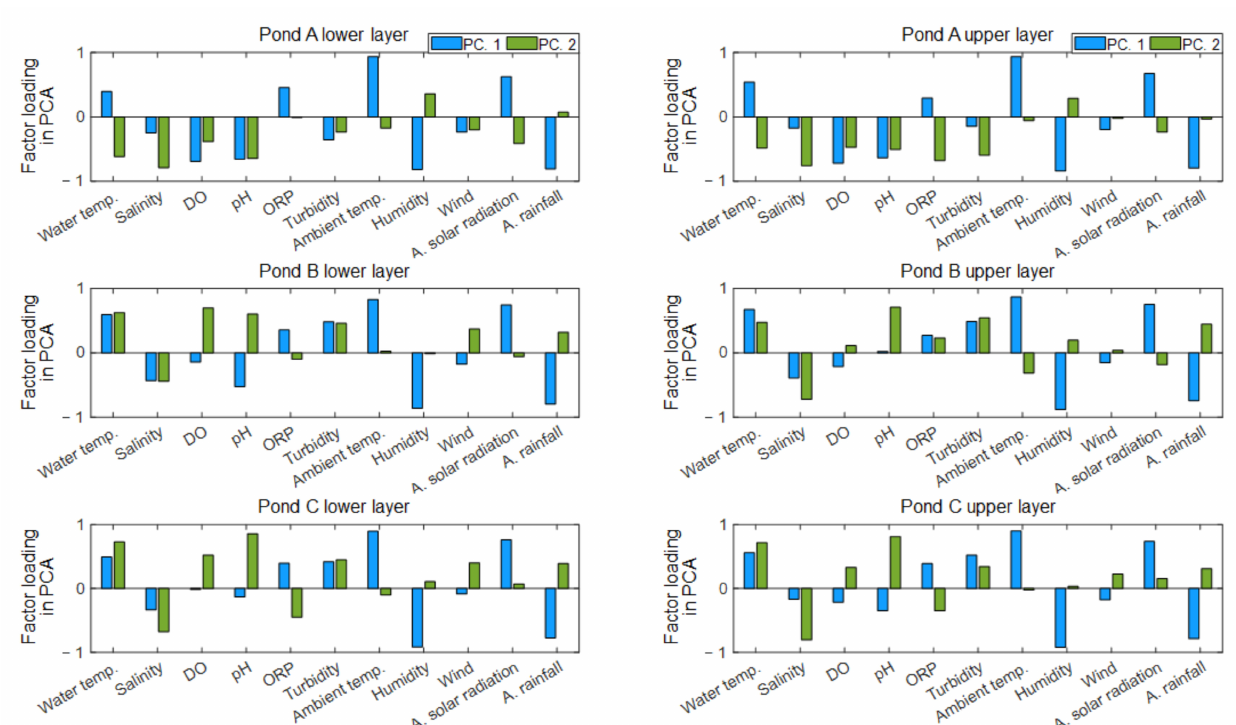
Figure 12. Factor loading by 1st and 2nd PCs for the non-heat storage period.